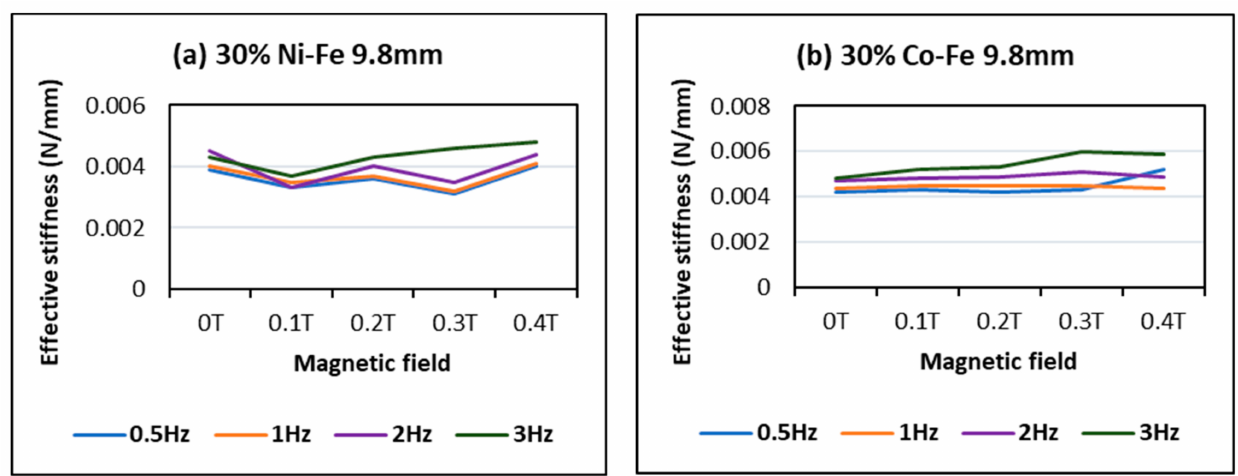
Figure 13. Effect of magnetic field and frequency on effective stiffness of ( a ) 30% Ni-Fe MRE and ( b ) 30% Co-Fe